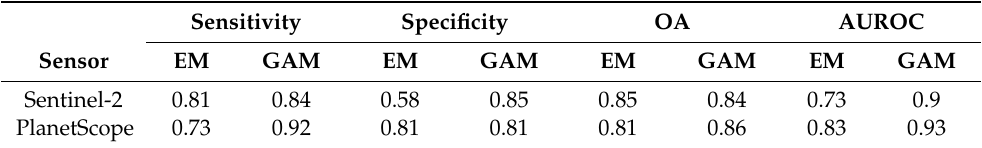
Table 3. Mapping accuracies using Expectation–Maximization (EM) and Generalized Additive Model (GAM) for Sentinel-2 and PlanetScope